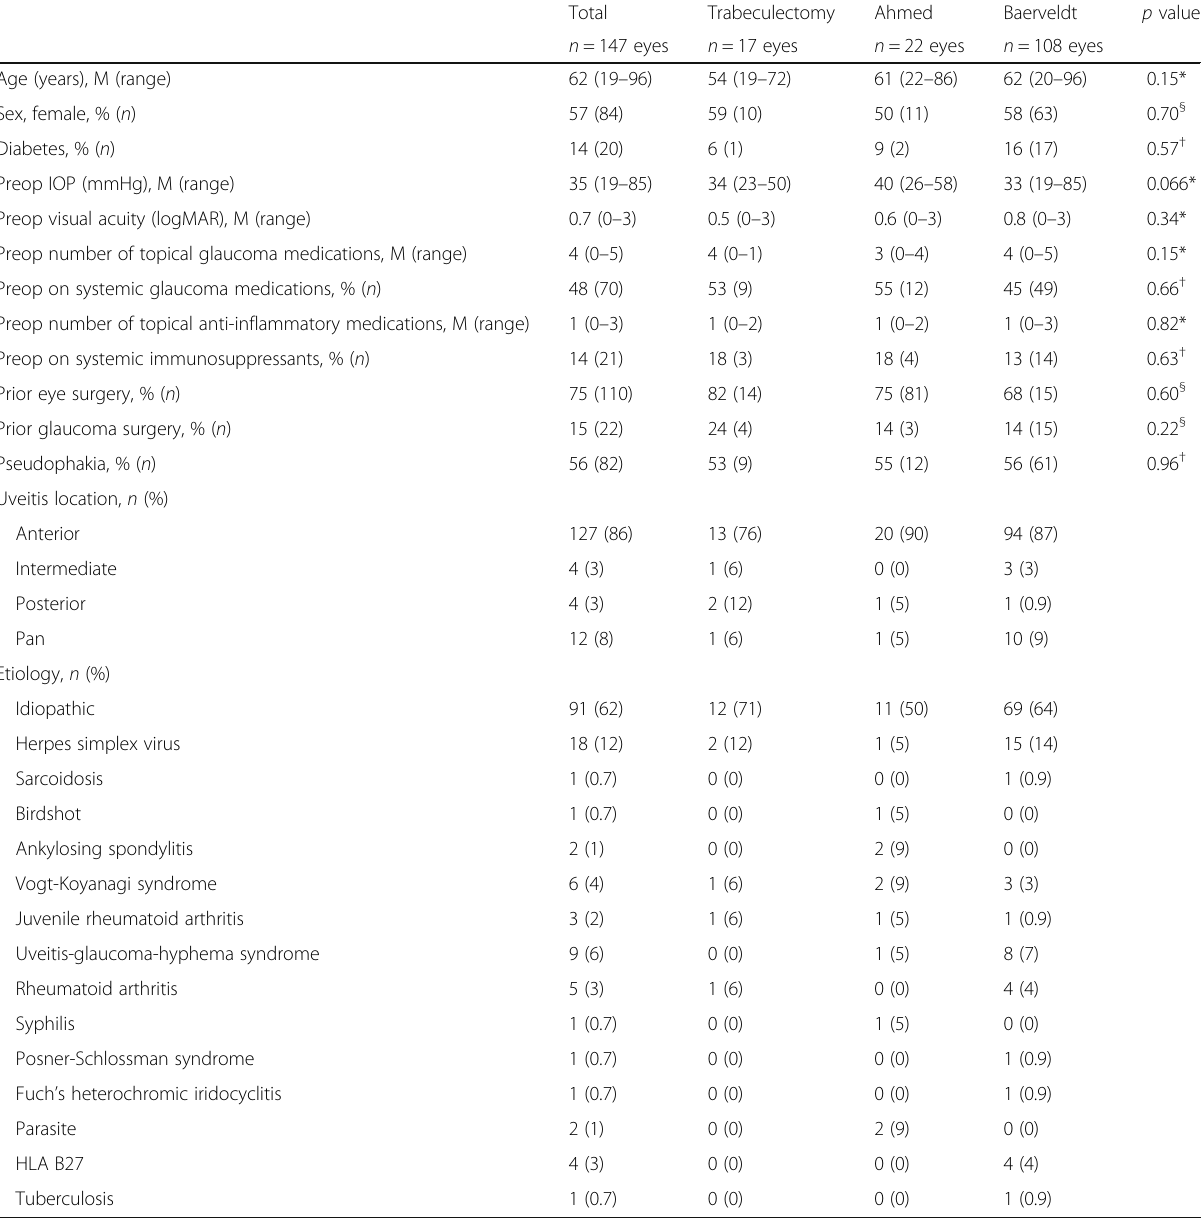
Table 1 Baseline demographics and ocular characteristics